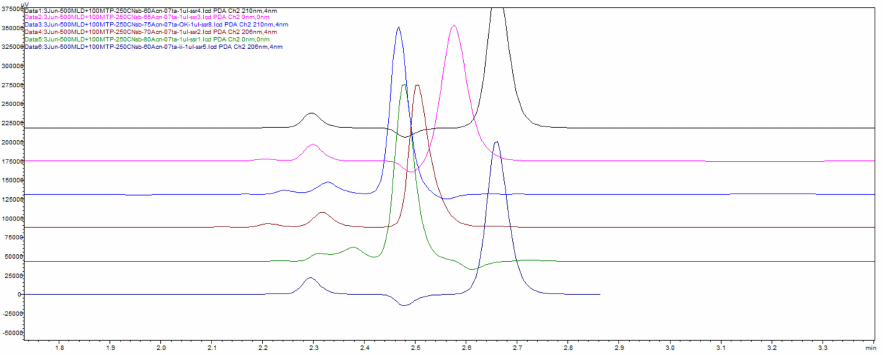
Figure 42. Chromatograms with TFA, a function of changes of percentage of ACN in 60–65–70–75–80% ACN, creating map of meldonium and metoprolol peak elution movement across the X-scale 60–80% increment of ACN.